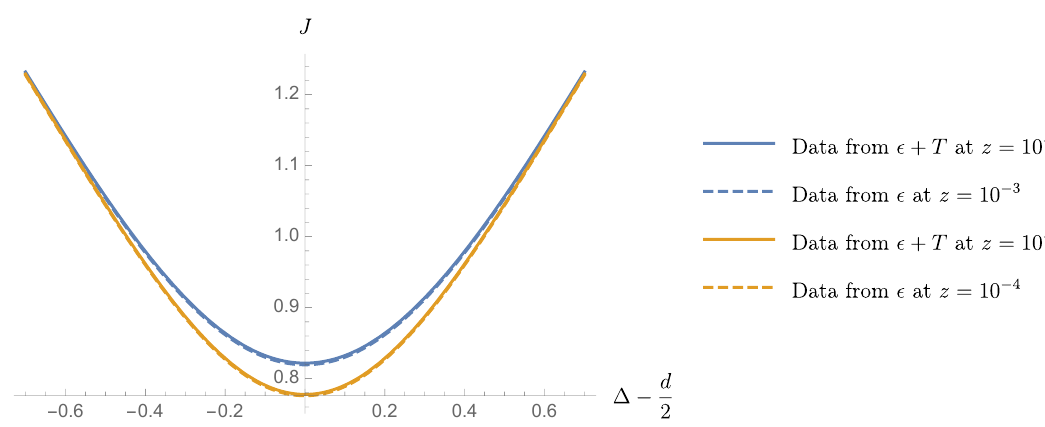
Figure 12 . The function J (∆) is plotted at low spin, for the exchange of (cid:15) and for the exchange of (cid:15) and stress-tensor at two different values of z . The important takeaway is that the spin of the intercept is below 1. The width created by these curves estimates the error of the